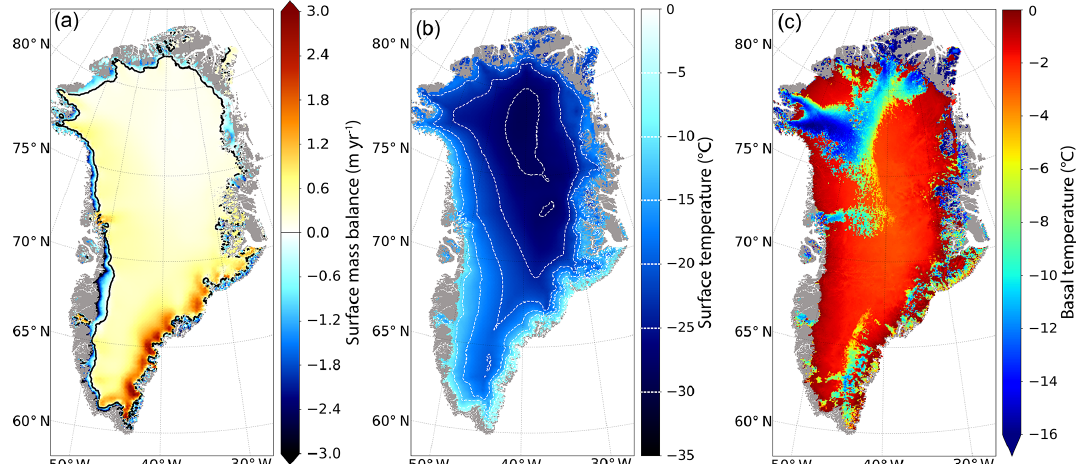
Figure 1. (a, b) Climate forcing averaged over the 1979–2005 period simulated by the atmospheric regional model MAR (Fettweis et al., 2013) and interpolated on the GRISLI ice sheet model grid (5km × 5km): mean surface mass balance (myr − 1 , i.e. 10 3 kgm − 2 yr − 1 ) with the black line representing the equilibrium line altitude, defined as the frontier between accumulation and ablation areas; mean annual surface temperature ( ◦ C) with the white dashed lines representing the 5 ◦ C iso-contours. In addition, (c) basal temperature difference with respect to the pressure melting point ( ◦ C) at the end of the 30000-year equilibrium temperature computation for a fixed topography.